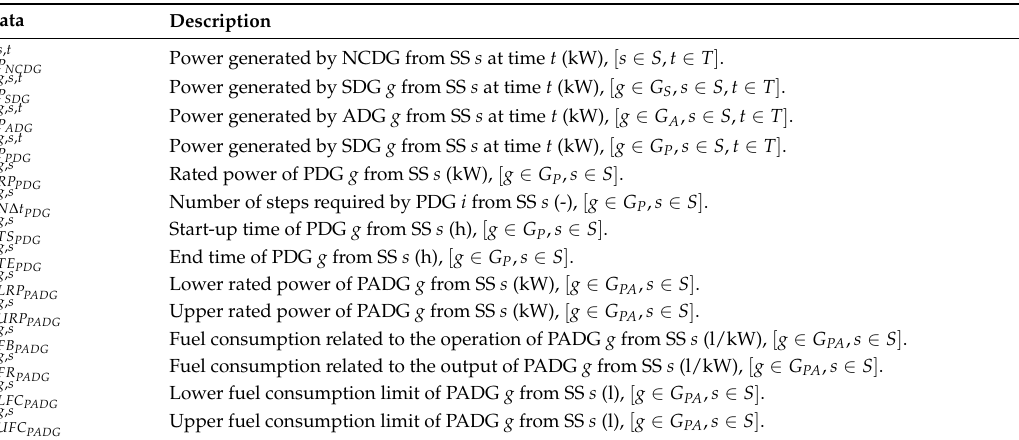
Table 5. Summary of input data (Distributed Generators (DG) parameters).